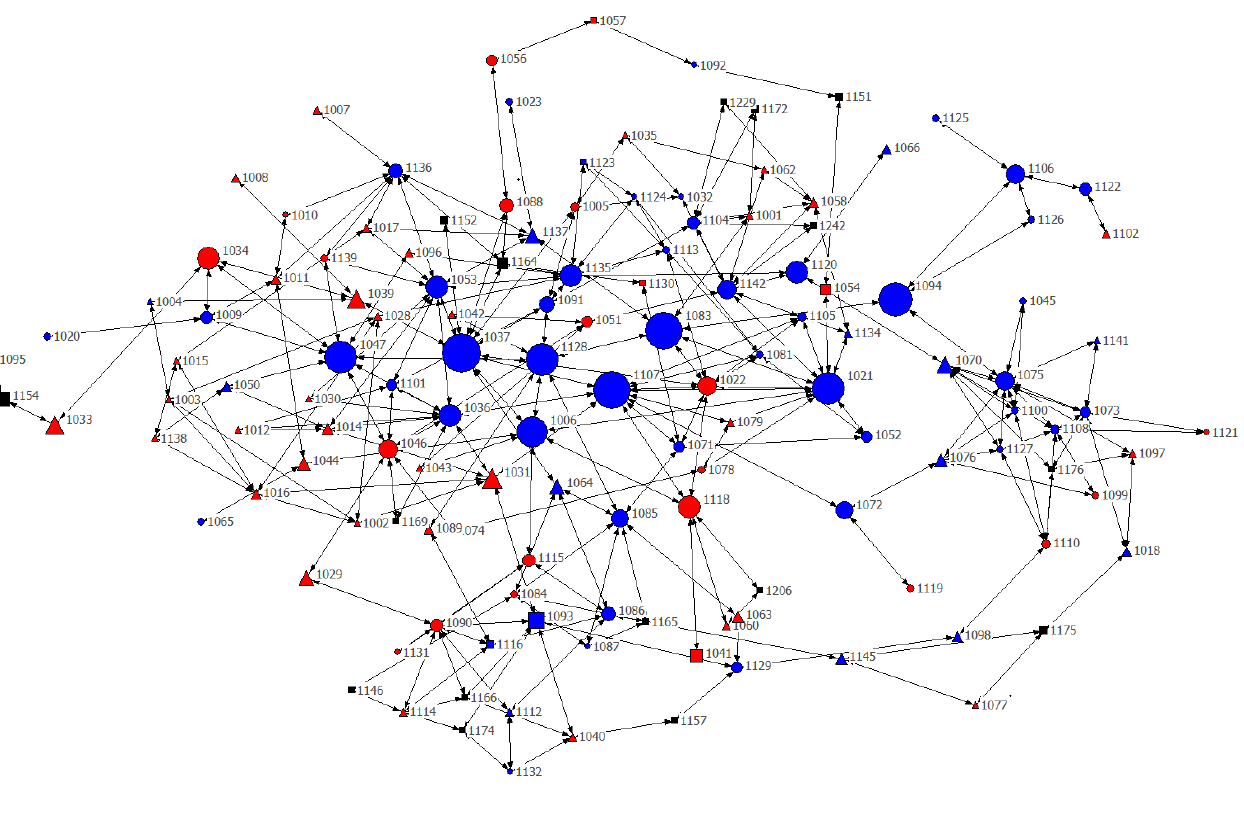
Fig. 9 . Money exchange network showing betweenness centrality † , Wealth Index ‡ , and gender of household head § .